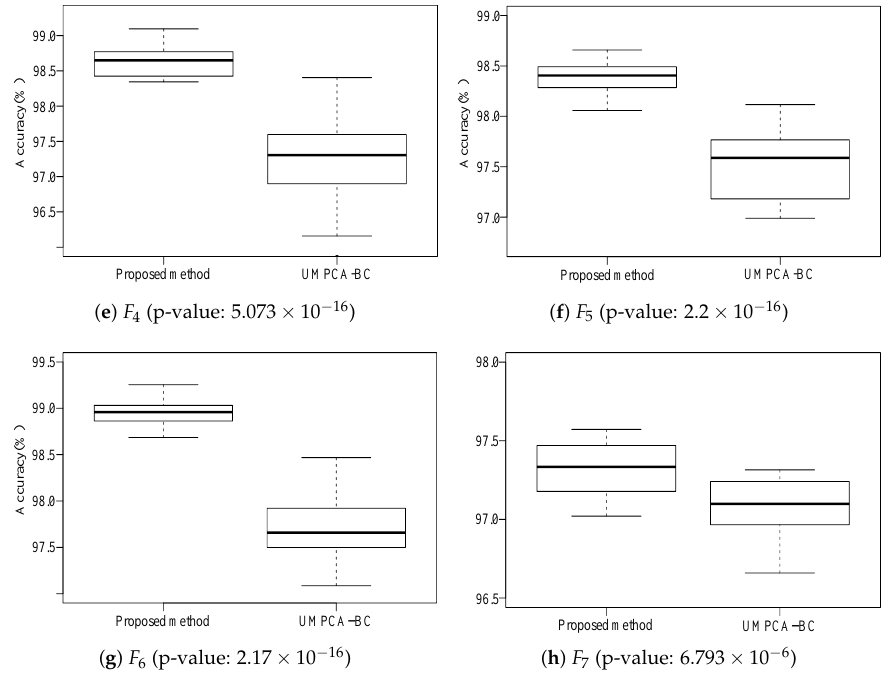
Figure 9. Performance comparison. Numbers in parentheses are the p -values of the Mann–Whitney U